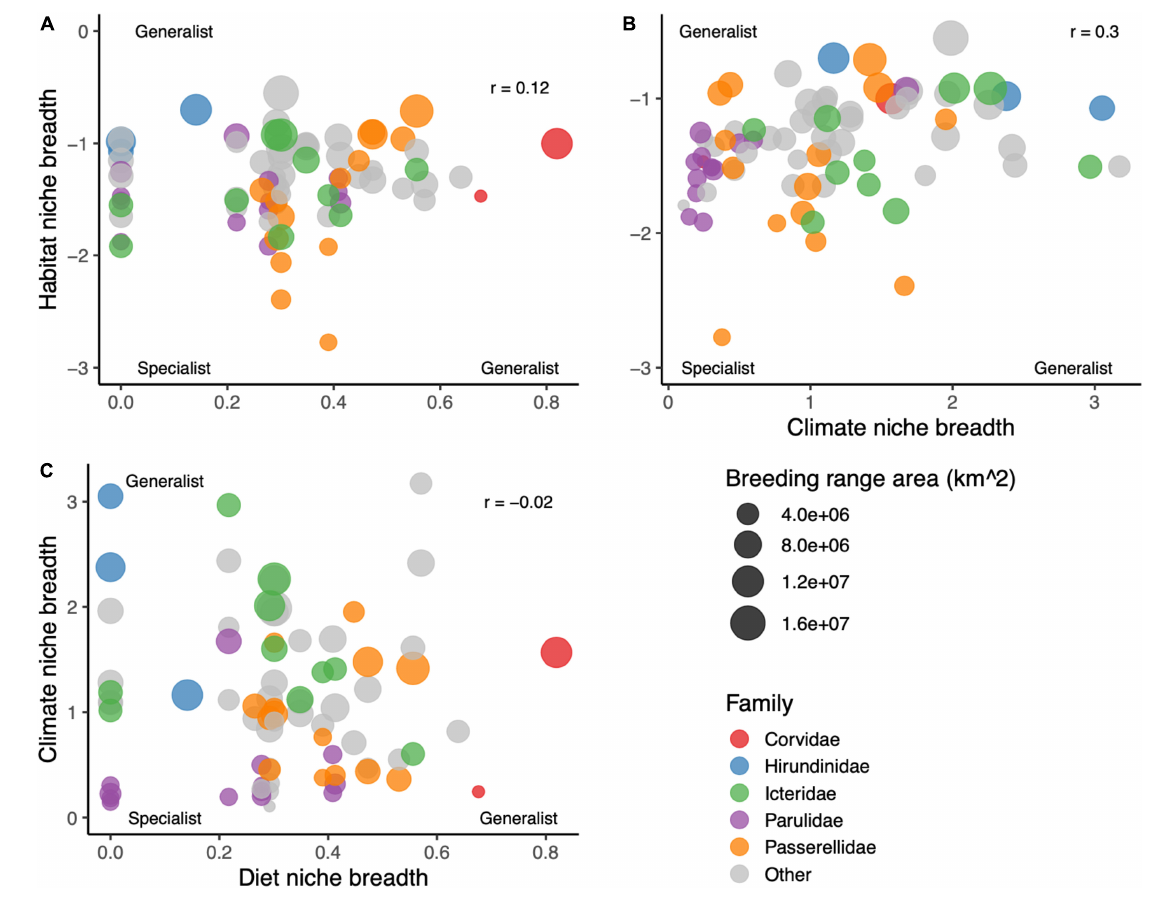
Frontiers in Ecology and Evolution